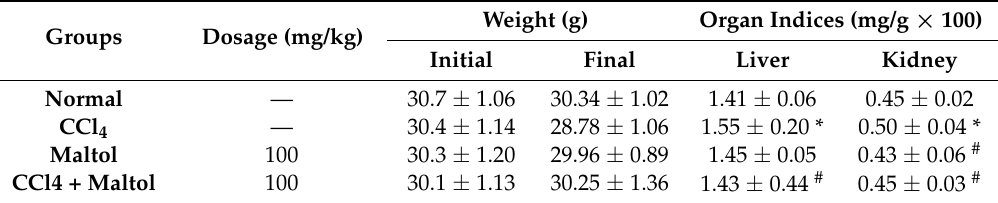
Table 1. Effects of maltol on body weight and organ weight in mice.